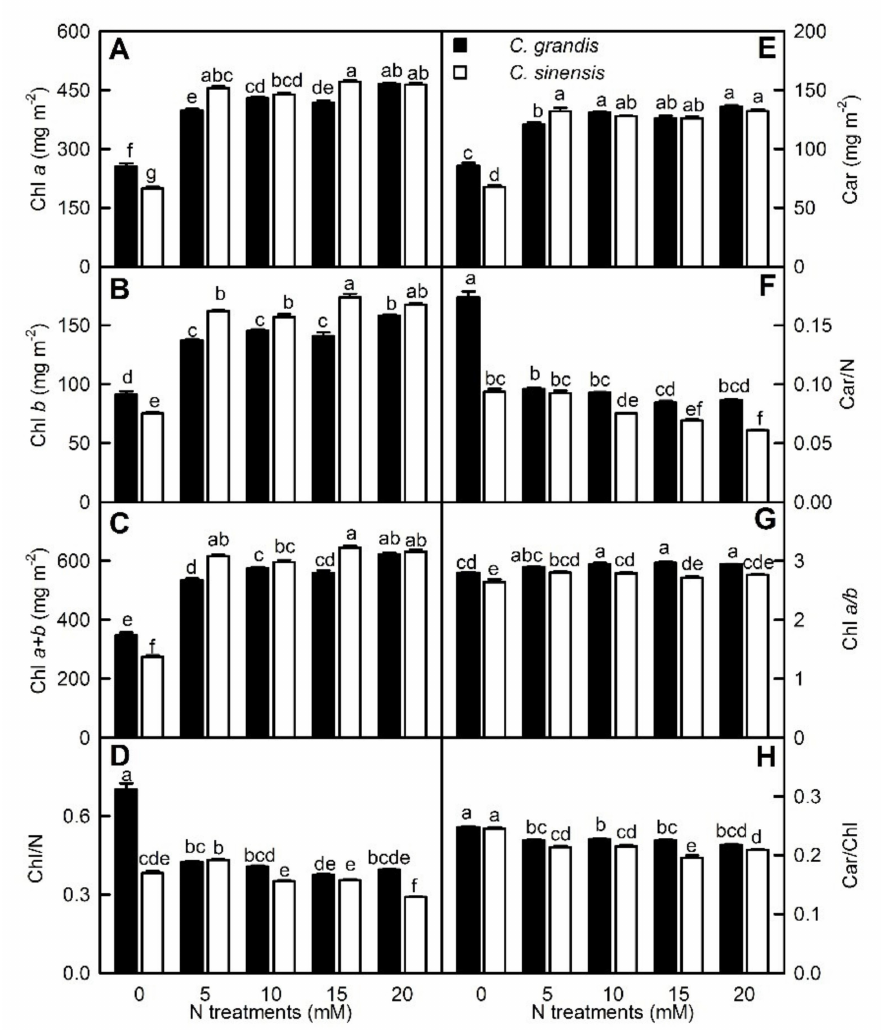
Figure 7. Effects of N supply on mean ( ± SE, n = 4) Chl a ( A ), Chl b ( B ), Chl a + b ( C ), Chl/N ( D ), carotenoids (Car, E ), Car/N ( F ), Chl a / b ( G ) and Car/Chl ( H ) in leaves. 3.6. Effects of N Supply on OJIP Transients and Related Parameters in Dark-Adapted Leaves We observed that the heterogeneity of samples (leaves) was greater at 0 mM N than at 5–20 mM N, and that OJIP transients from N deficiency C. grandis and C. sinensis leaves had greatly increased O-step, slightly increased ( C. sinensis ) or unaltered ( C. grandis ) P-step, positive ∆ L-, ∆ K-, ∆ J-, and ∆ I-bands, positive ∆ O-K , ∆ O-J and ∆ J-I bands, but negative ∆ I-P bands compared with OJIP transients from 20 mM N-treated leaves, with greater alterations of ∆ L-bands, ∆ K-bands and ∆ I-P bands and less alterations of ∆ J-I bands in N deficiency C. sinensis than in N deficiency C. grandis leaves. Few, if any, differences existed among the OJIP transients from the 5, 10, 15 and 20 N-treated leaves (Figures 8 and